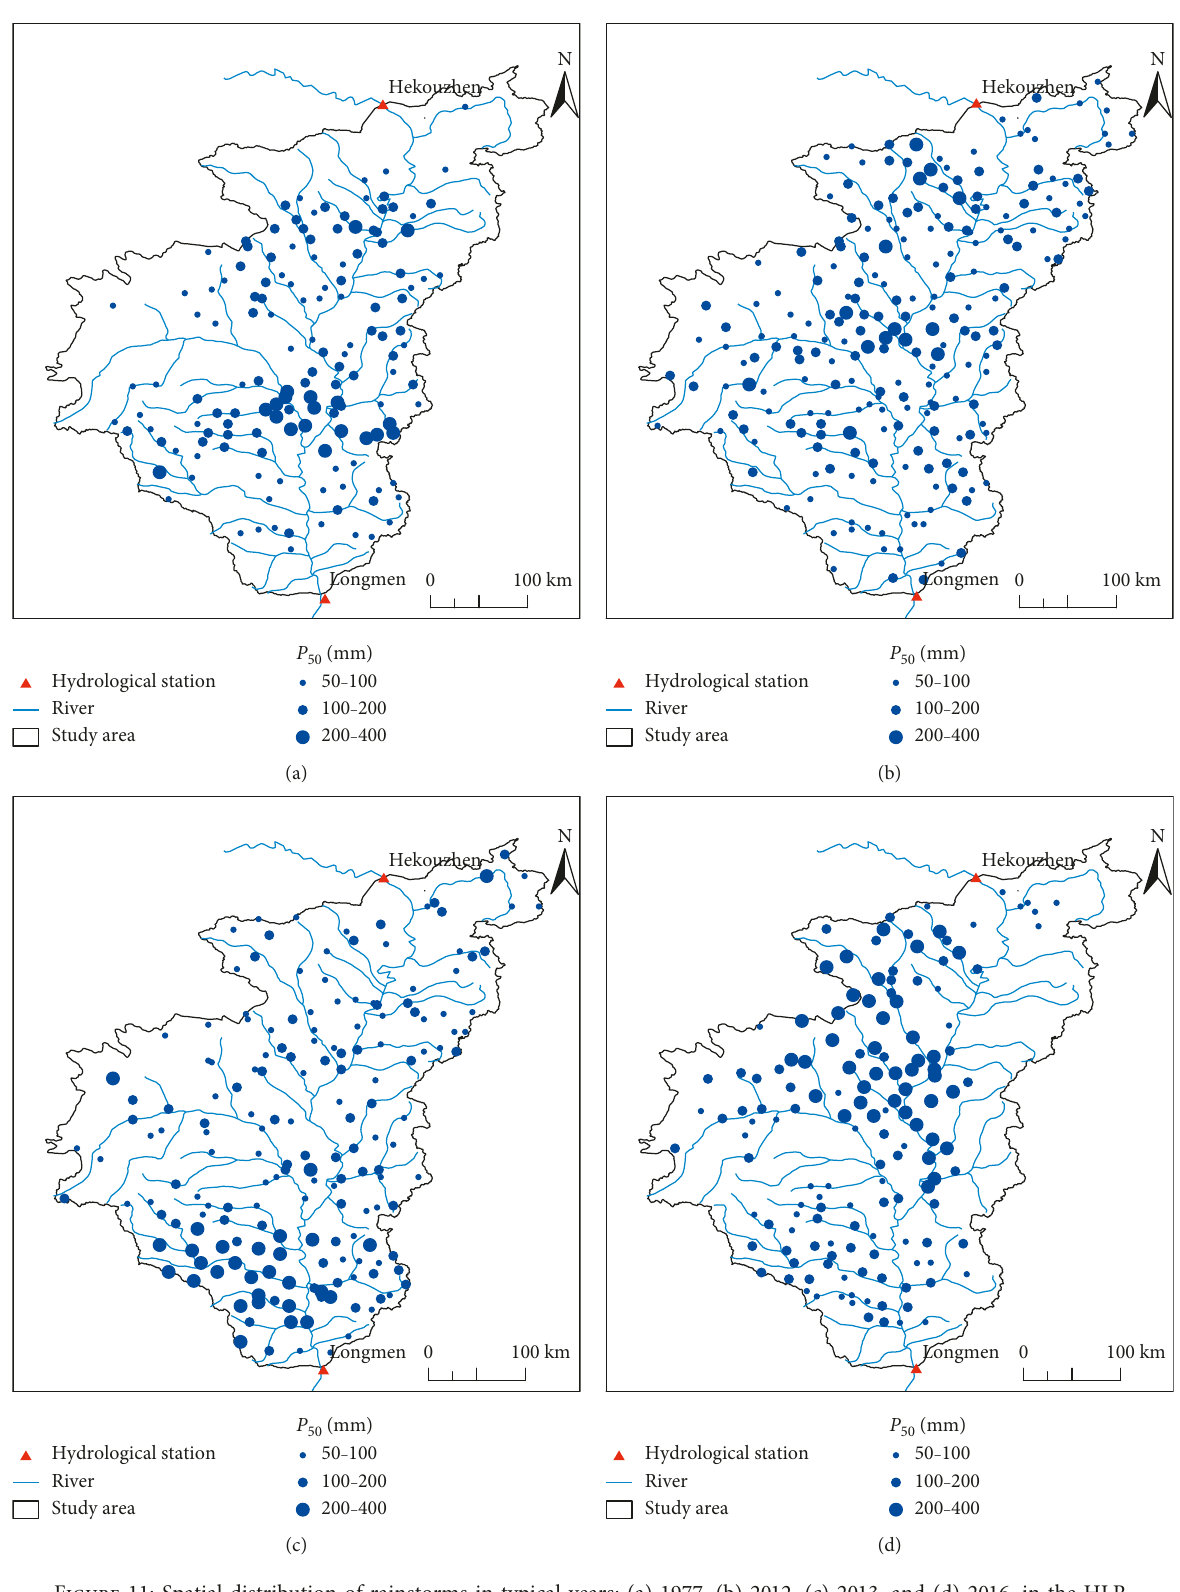
Figure 11: Spatial distribution of rainstorms in typical years: (a) 1977, (b) 2012, (c) 2013, and (d) 2016, in the